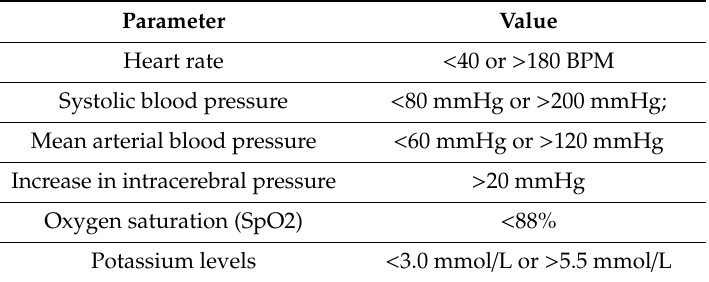
Table 2. Training termination criteria